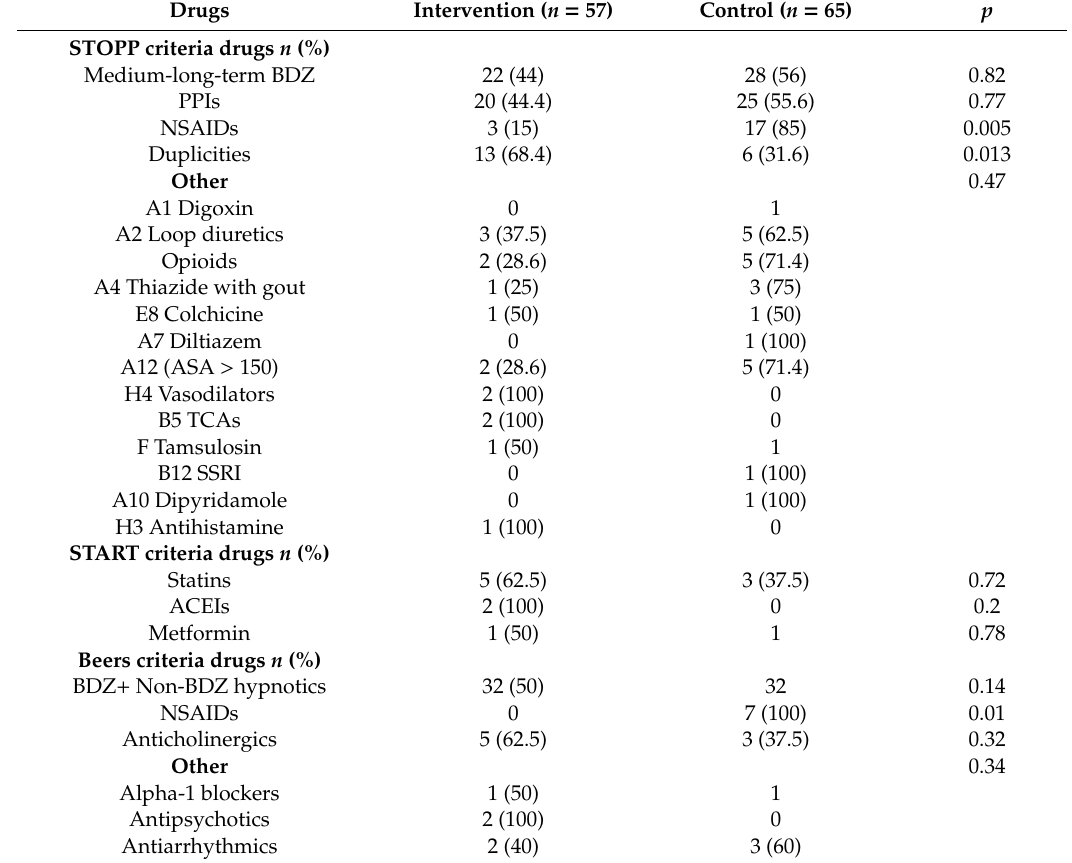
Table 2. Types of drugs according to the STOPP, Beers and START criteria prescribed for each group